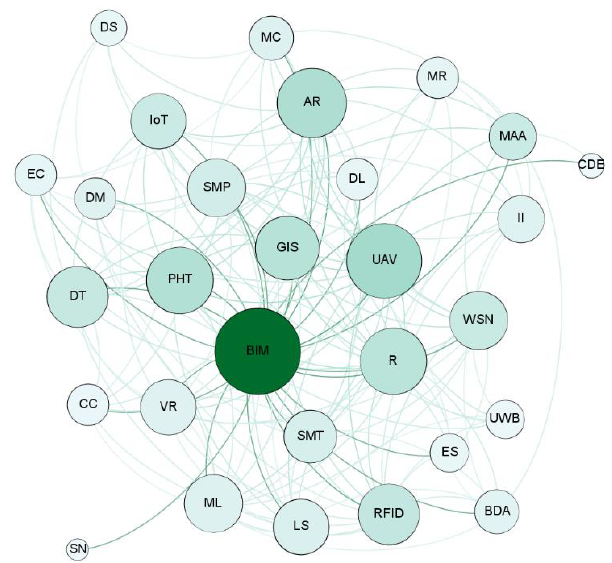
Figure 9. Full network analysis—betweenness.